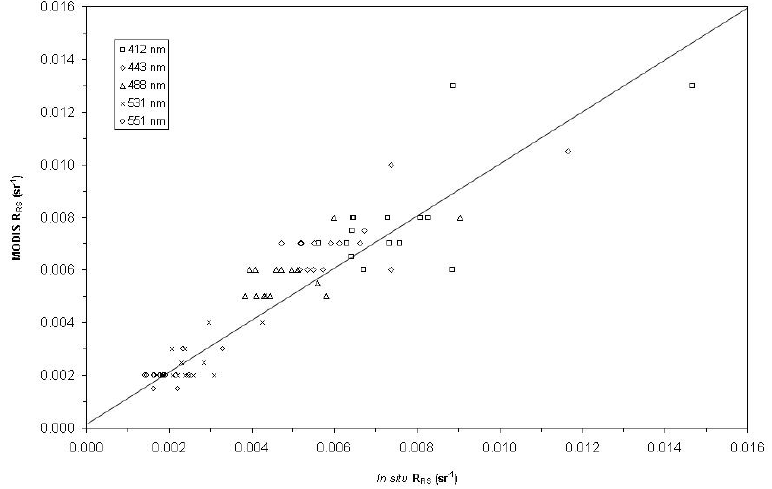
Figure 6. Scatter plot of MODIS remote sensing reflectance ( R above-water R for 15 stations where inter-comparison were RS